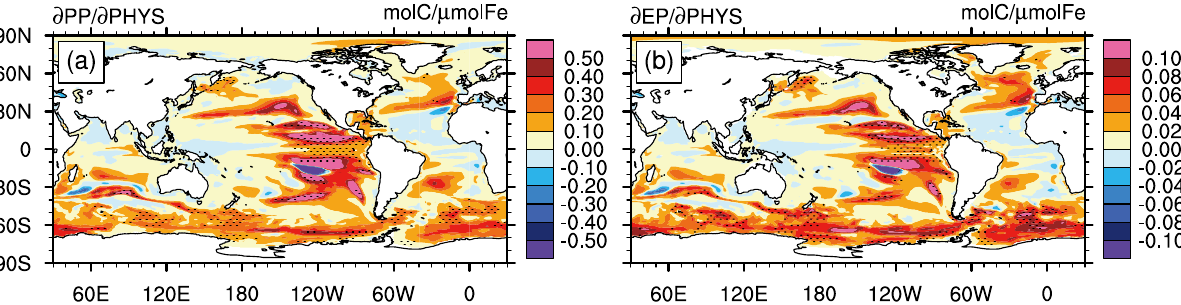
Fig. 16. Spatial distributions of linear regression slopes between (a) primary production and (b) export production and the dissolved iron supply due to the PHYS term (molC, µmolFe − 1 ) . The regressions were calculated using the temporal variations of annual means during the 1990–2099 period. Regions with R 2 values exceeding 0.5 are dotted (IRON-DRIVEN-AREA, see